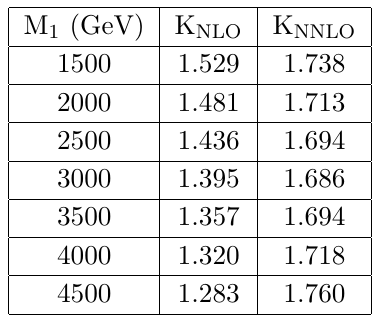
Table 2 . The (cid:12)xed order K-factors for the signal to NNLO in QCD right at the resonance region for di(cid:11)erent M 1 values are presented for 13 TeV LHC.